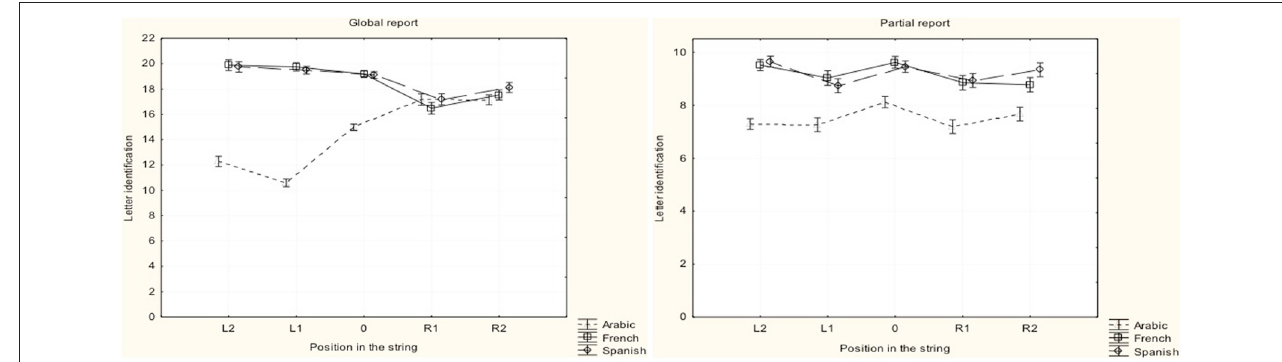
FIGURE 2 | Response patterns on the VA span tasks of global and partial report for the Arabic, French and Spanish participants. Letter position labels are provided by reference to the fixation point, regardless of reading direction. 0, fixation point; L2, L1, leftward positions; R1, R2, rightward positions.